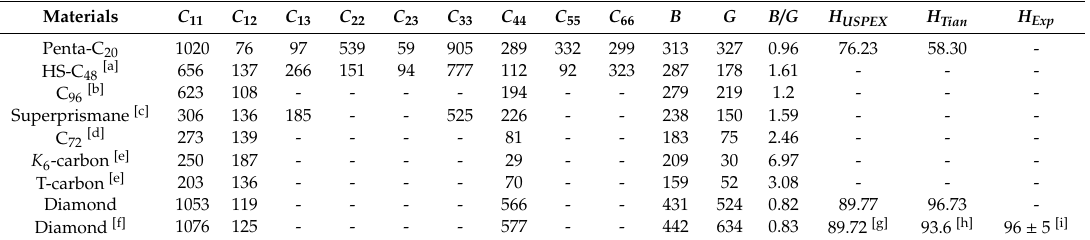
Table 2. The calculated elastic constants (C ij , in GPa), elastic modulus ( B and G , in GPa), and hardness ( H USPEX , H Tian and H Exp , in GPa) for Penta-C 20 and other carbon allotropes. Materials C